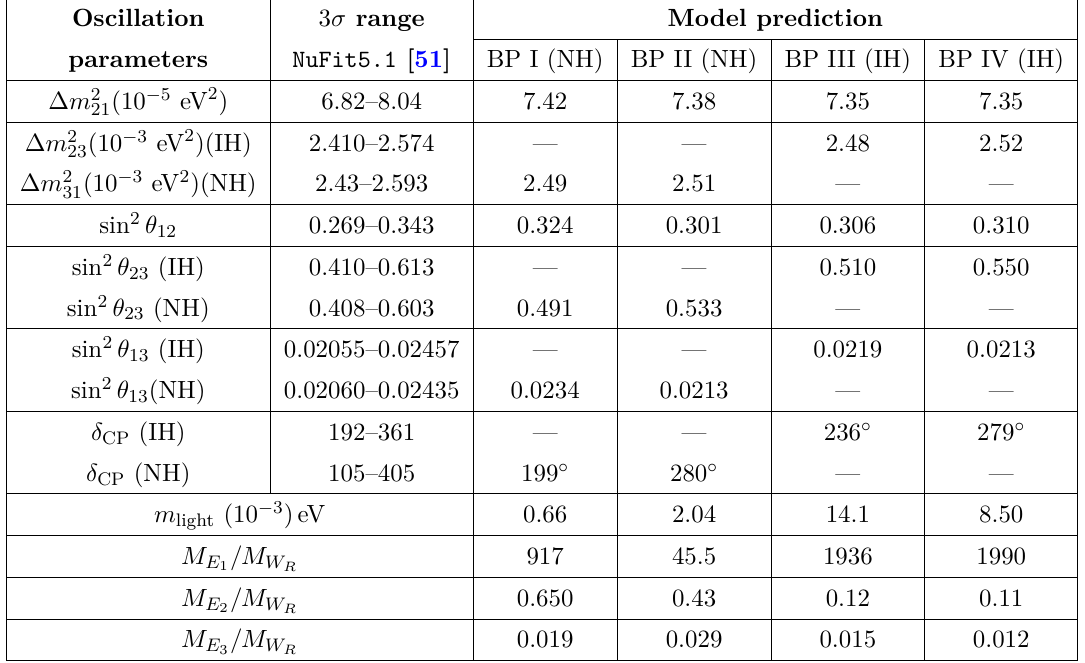
Table 1. Fits to the neutrino oscillation parameters in the model with normal and inverted hierarchy. For comparison, the 3 σ allowed range for the oscillation parameters are also